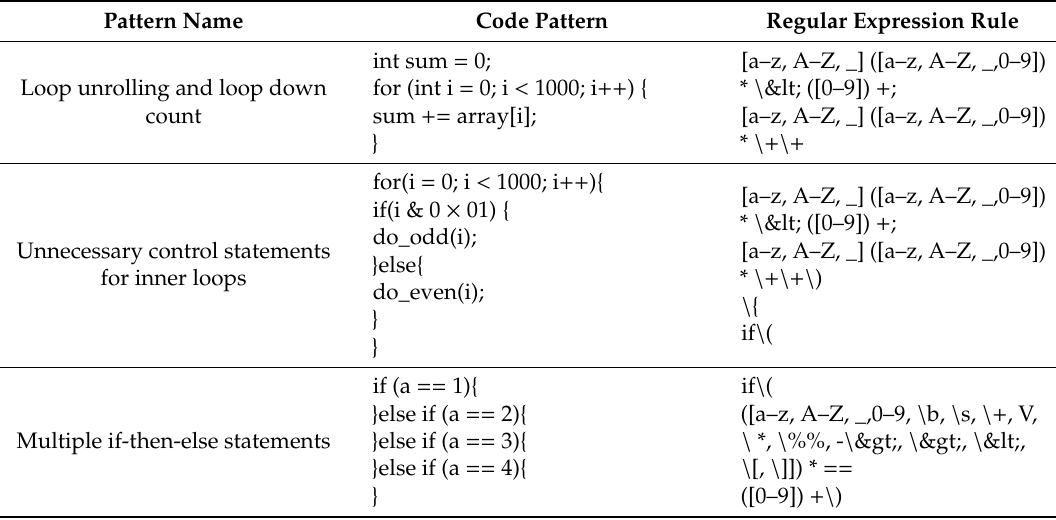
Table 1. Patterns and rules for performance degraded